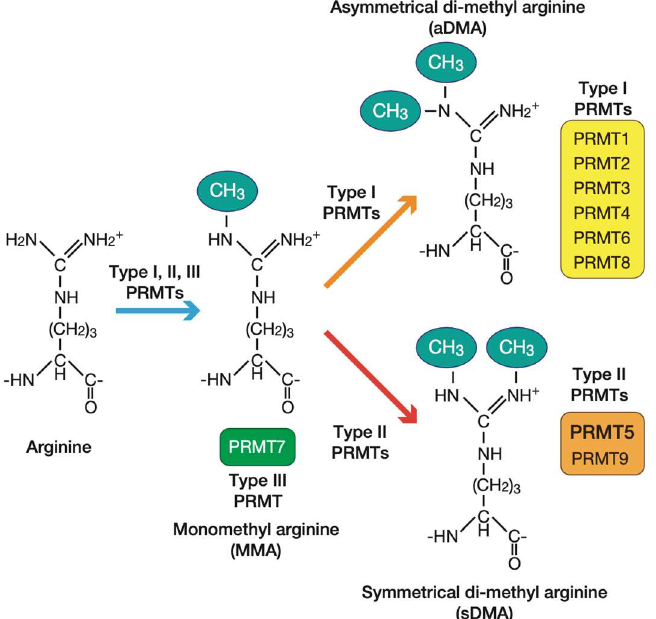
Figure 3. Protein arginine methyltransferase (PRMT)-mediated arginine methylation. All PRMT